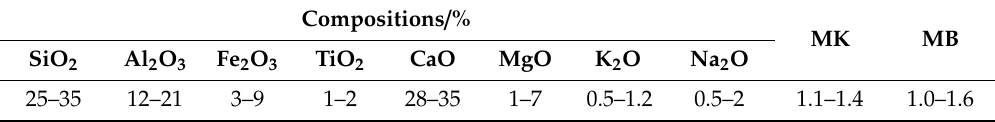
Figure 9. Production process of RM inorganic fiber [92]. Table 6. Compositions of RM inorganic fiber [92].